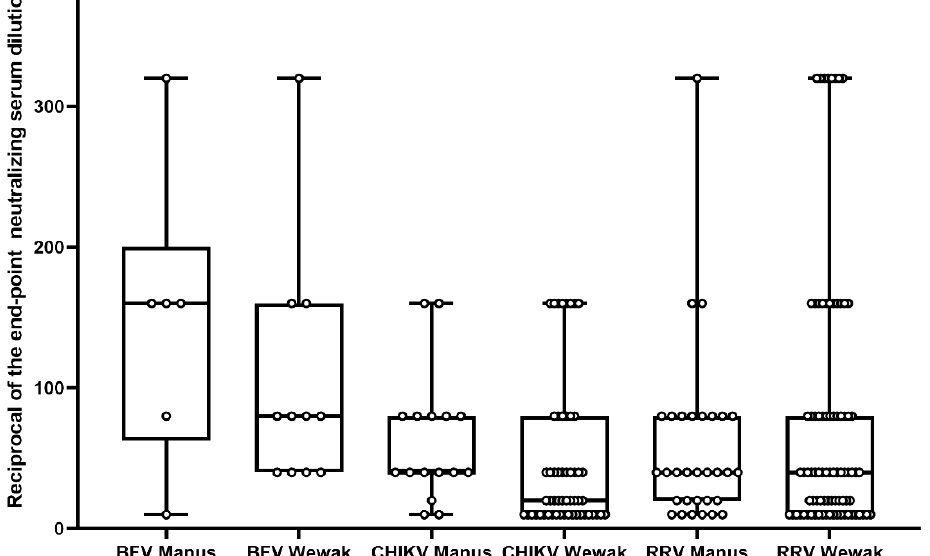
Figure 2. Box plot illustrates neutralizing antibody concentrations of three alphaviruses among Papua New Guinea Military Personnel located in Wewak and Manus Island, 2019. The y-axis represents the reciprocal end-point neutralizing serum dilutions. Box plots show the median (horizontal line) and the min to max of neutralizing antibody titers. All positive serum samples are included. Table 2. Prevalence of anti-Barmah Forest virus, anti-Chikungunya virus and anti-Ross River virus antibodies, observed in 204 Papua New Guinea military participants in this study in 2019.